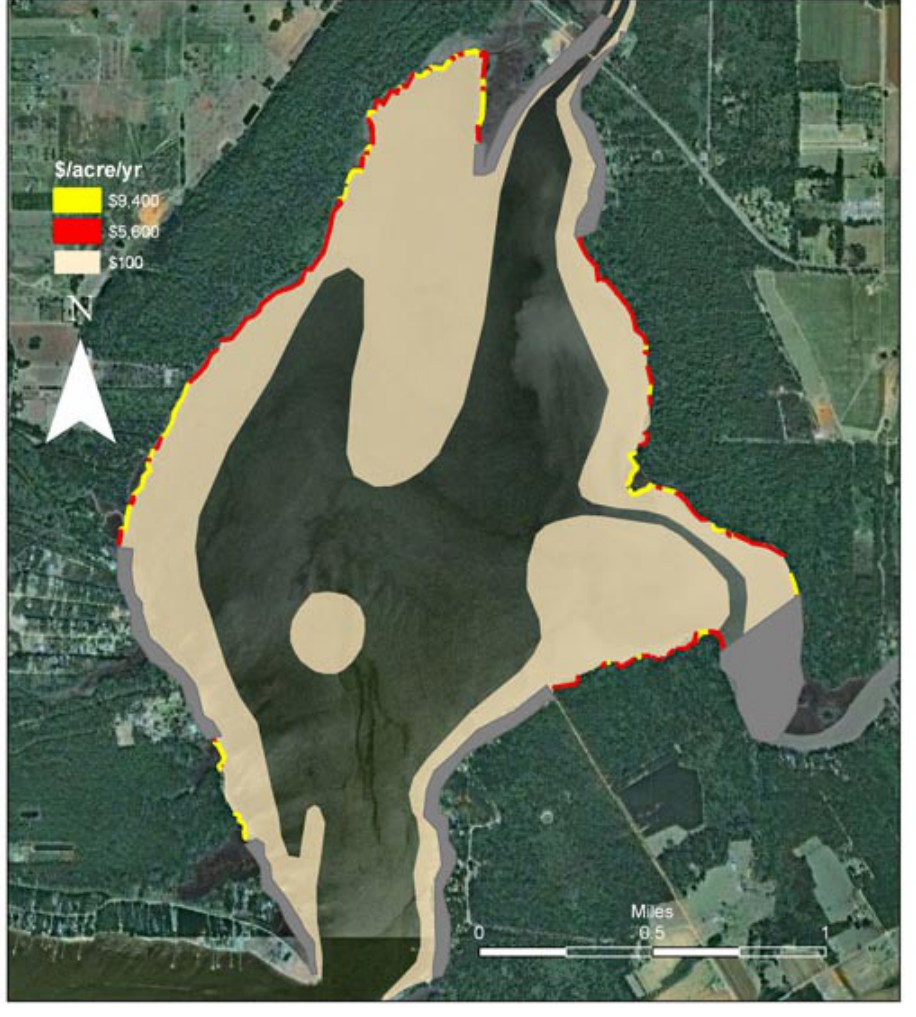
Fig. 6. Combined map of the commercial and recreational fisheries habitat value of three habitat types in Weeks Bay,